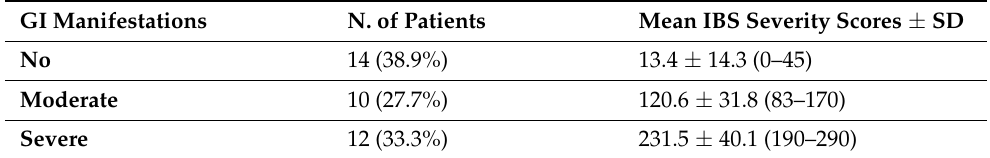
Table 3. IBS severity score in all FD patients assessed (n. 36): 33.3% presented severe GI manifestations (IBS severity score > 175), 27.7% moderate (75 > IBS severity score > 175), and 38.9% did not show GI